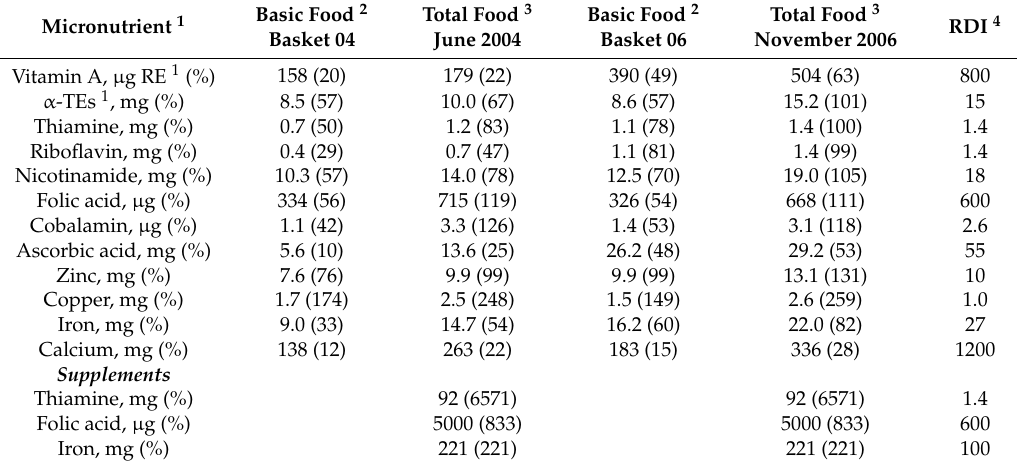
Table 2. Estimated daily micronutrient intake by provided food rations and supplements for pregnant women in 2006 vs. 2004.